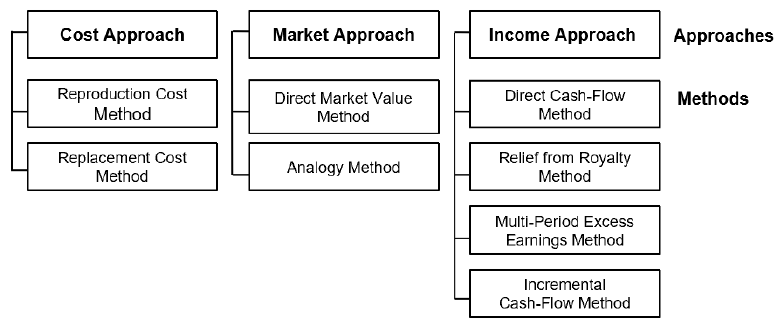
Figure 1. Valuation approaches and methods.